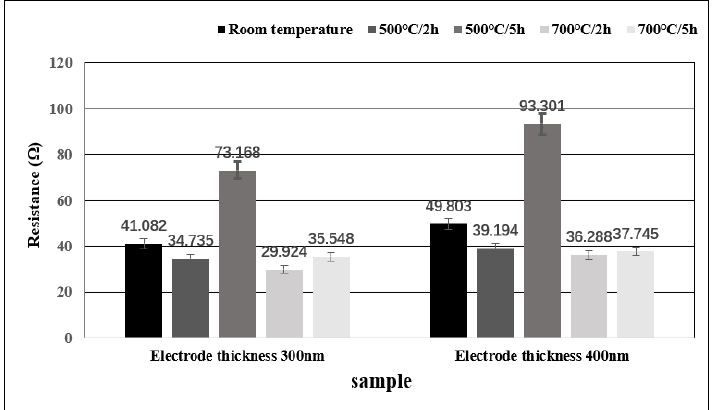
Figure 7. Histogram depicting the resistance change of the initial wire bonding sample at room temperature and after